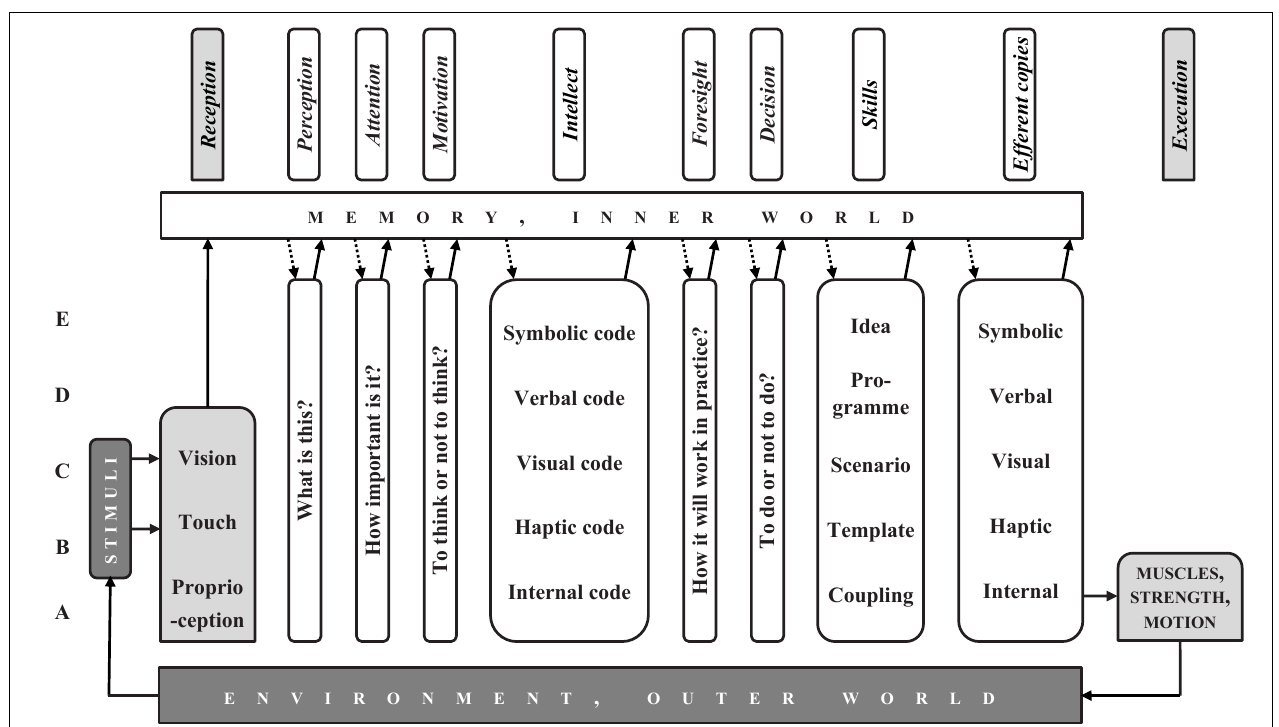
FIGURE 2 | Column Diagram” of information processing in a sensorimotor response. Dark blocks, physics; light grey blocks, physiology; white blocks,